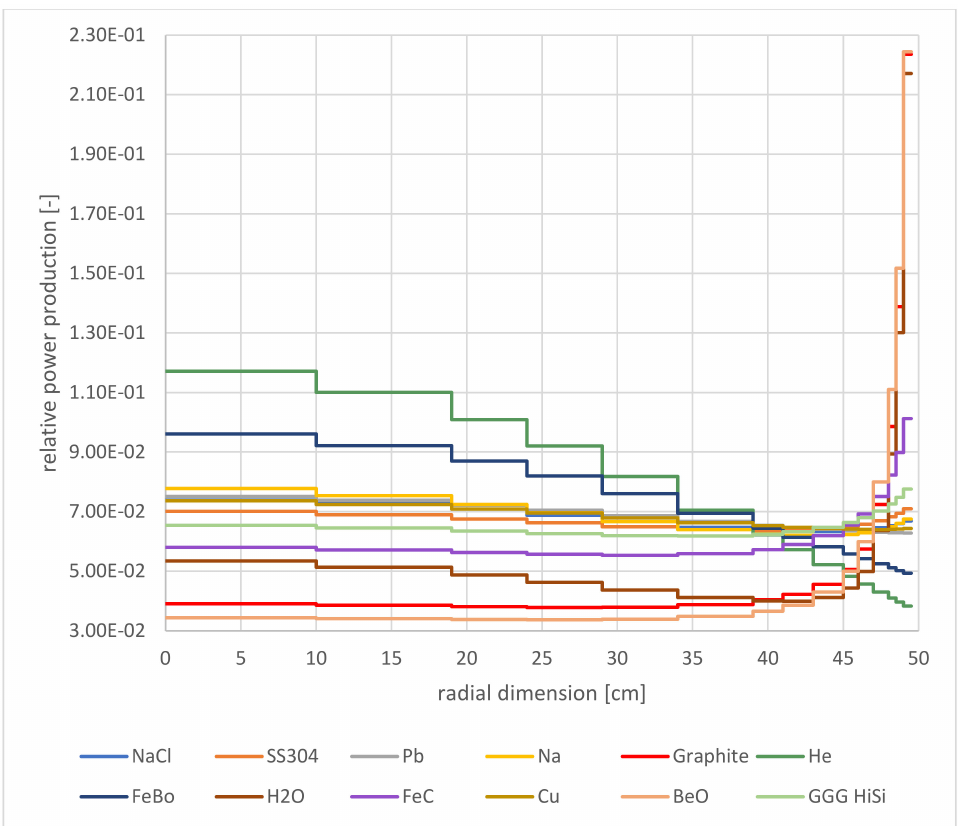
Figure 8. Radial power distribution investigated in a 2D system for different reflector materials for a zero-power experimen- tal